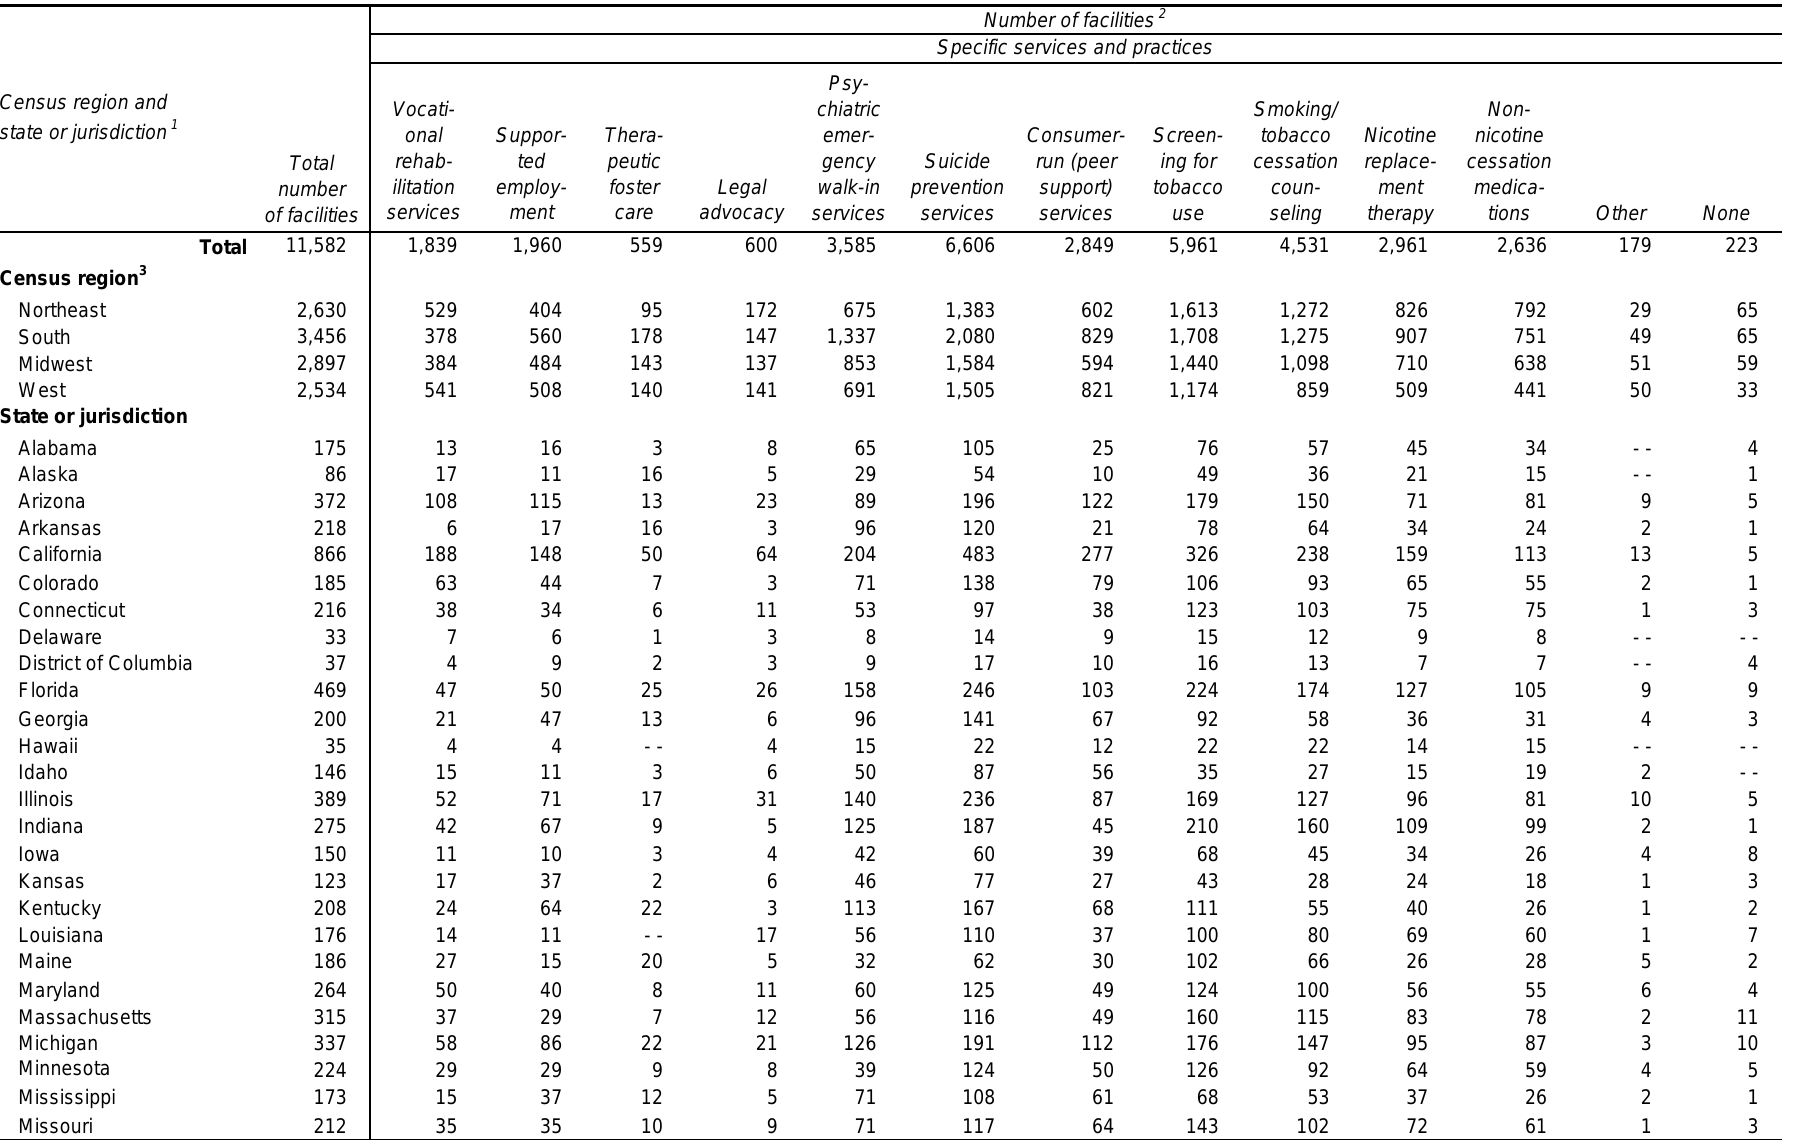
Table 3.8a. Mental health treatment facilities offering specific services and practices, by Census region and state or jurisdiction: Number, 2017